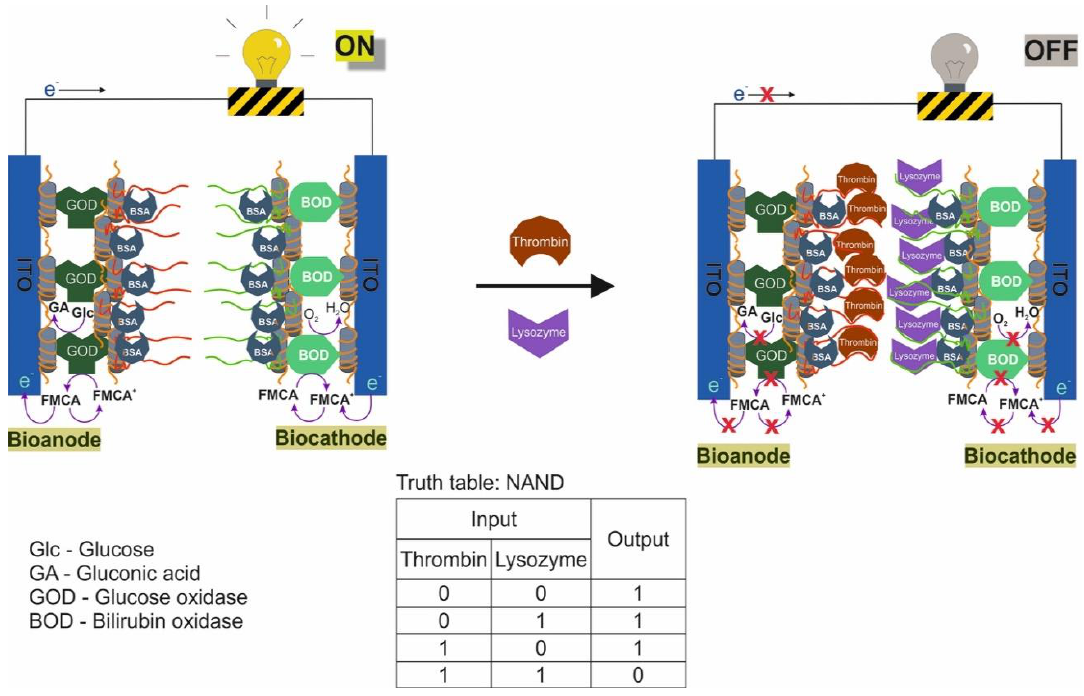
Figure 15. Logic gate INHIBIT. Adapted from Reference [129]. Copyright © 2020, American Chemical Society.